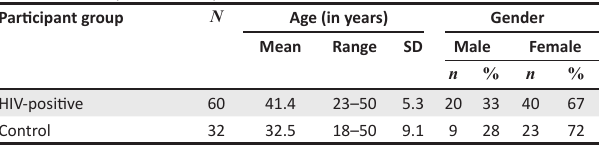
= 60] and HIV-negative participants [ N 1